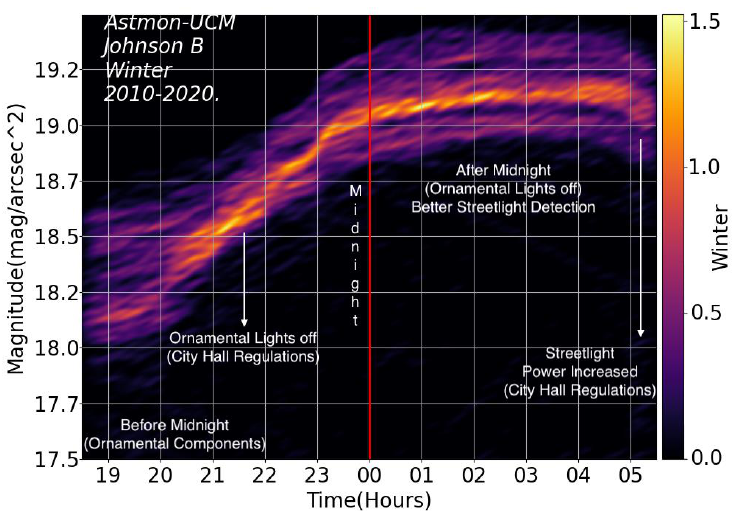
Figure 17. Detail of the winter curve with some anthropogenic factors annotated.